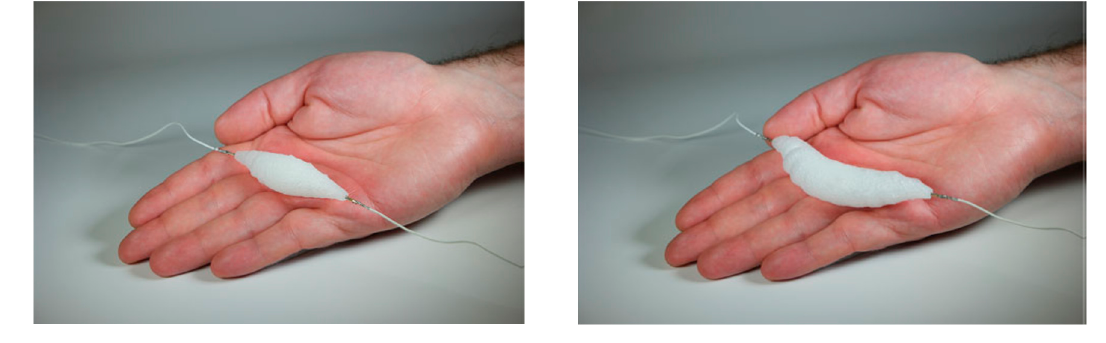
Figure 2. Silicone-ethanol muscle. Muscle was made of ethanol embedded in a silicone elastomer. The muscle shown is being thermally actuated using an internal heating element that is connected to a power supply. Reproduced from Miriyev, A.; Stack, K.; Lipson, H. Soft material for soft actuators [5]. Published by Nat. Commun. 2017, under the terms of the Attribution 4.0 International (https://creativecommons.org/licenses/by/4.0/).